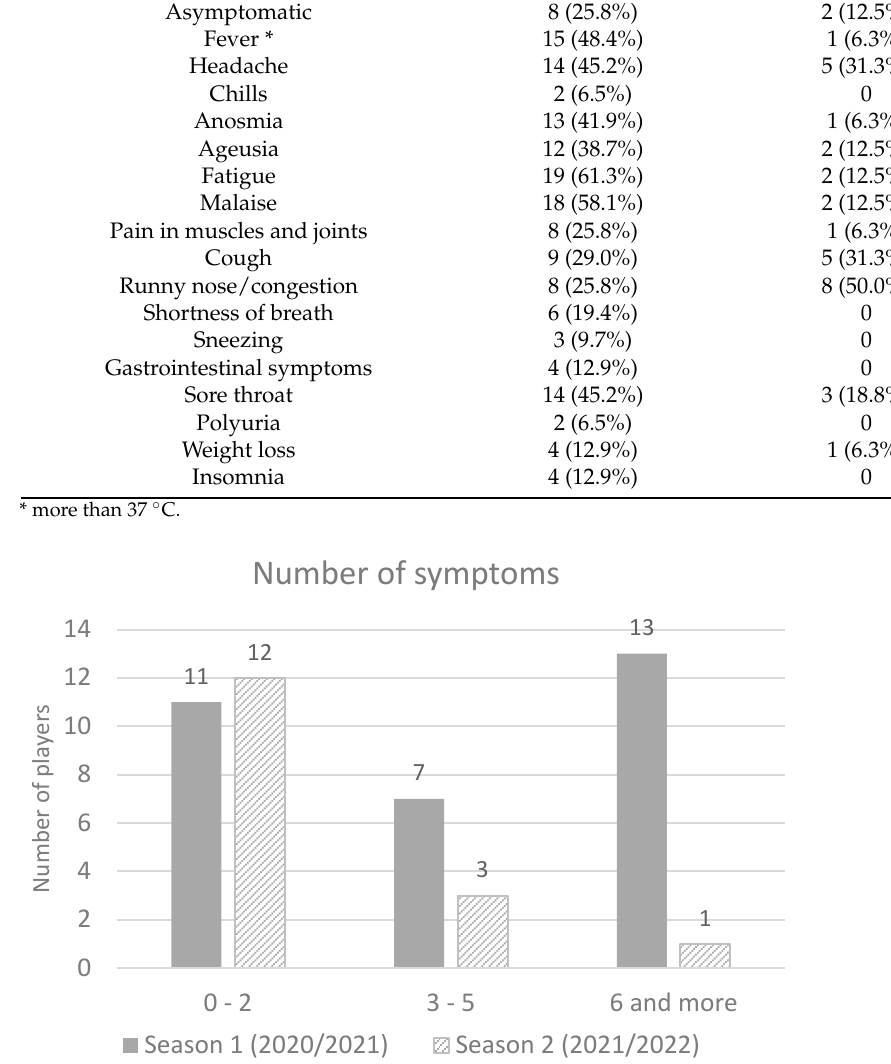
Figure 2. Number of symptoms in season 2020/2021 and season 2021/2022. Among infected players in season 1, no significant difference was found in the average number of symptoms per player for those who were infected for the first time vs. those who were reinfected ( t -test = 1.423, p = 0.181) with the mean value of 2.9 for the first time infected, and 2.7 for the reinfected players. During season 1, 67.7% of players had no physical activity for 10 or more days (average 10.3 days), while in season 2, most players (56.3%) had no physical activity for up to 4 days (average 5.1 days) which was found to be a significant difference ( χ 2 = 10.000; p = 0.006) (Figure 3a). It was found that the number of symptoms significantly predicted the number of days with no physical activity. The fitted regression model was: y = 0.7634x + 5.3759. The overall regression was statistically significant (R 2 = 0.3177, F(1, 45) = 20.9523, p < 0.001) (Figure